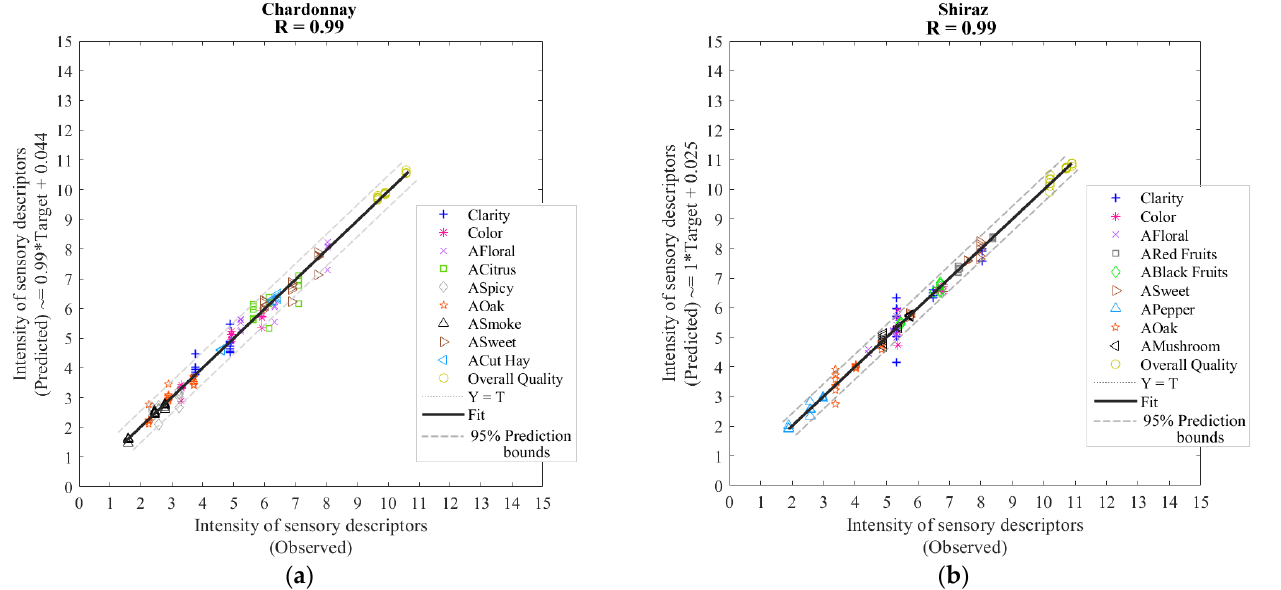
Figure 6. Overall artificial neural network regression models developed using the canopy architecture parameters as inputs to predict the intensity of sensory descriptors for ( a ) Chardonnay (Model 3) and ( b ) Shiraz (Model 4). Abbreviations: T: targets; R: correlation coefficient.